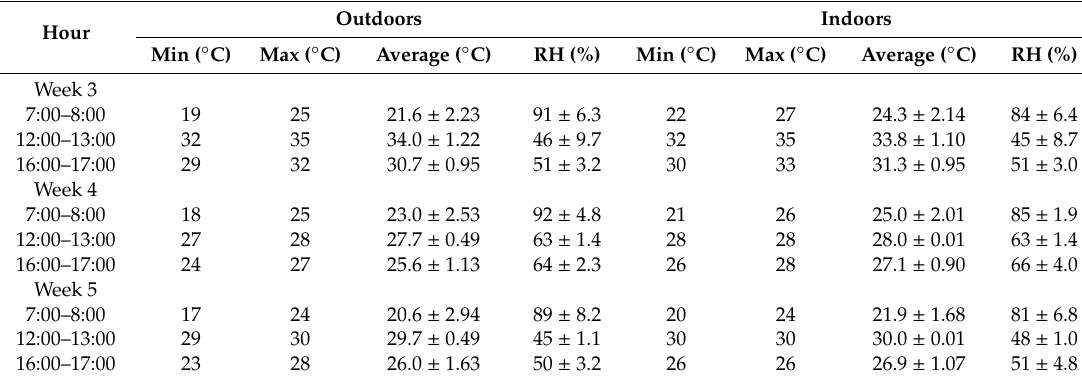
Table 2. Dry bulb temperature ( ◦ C) and relative humidity (RH, %) with standard deviations recorded during